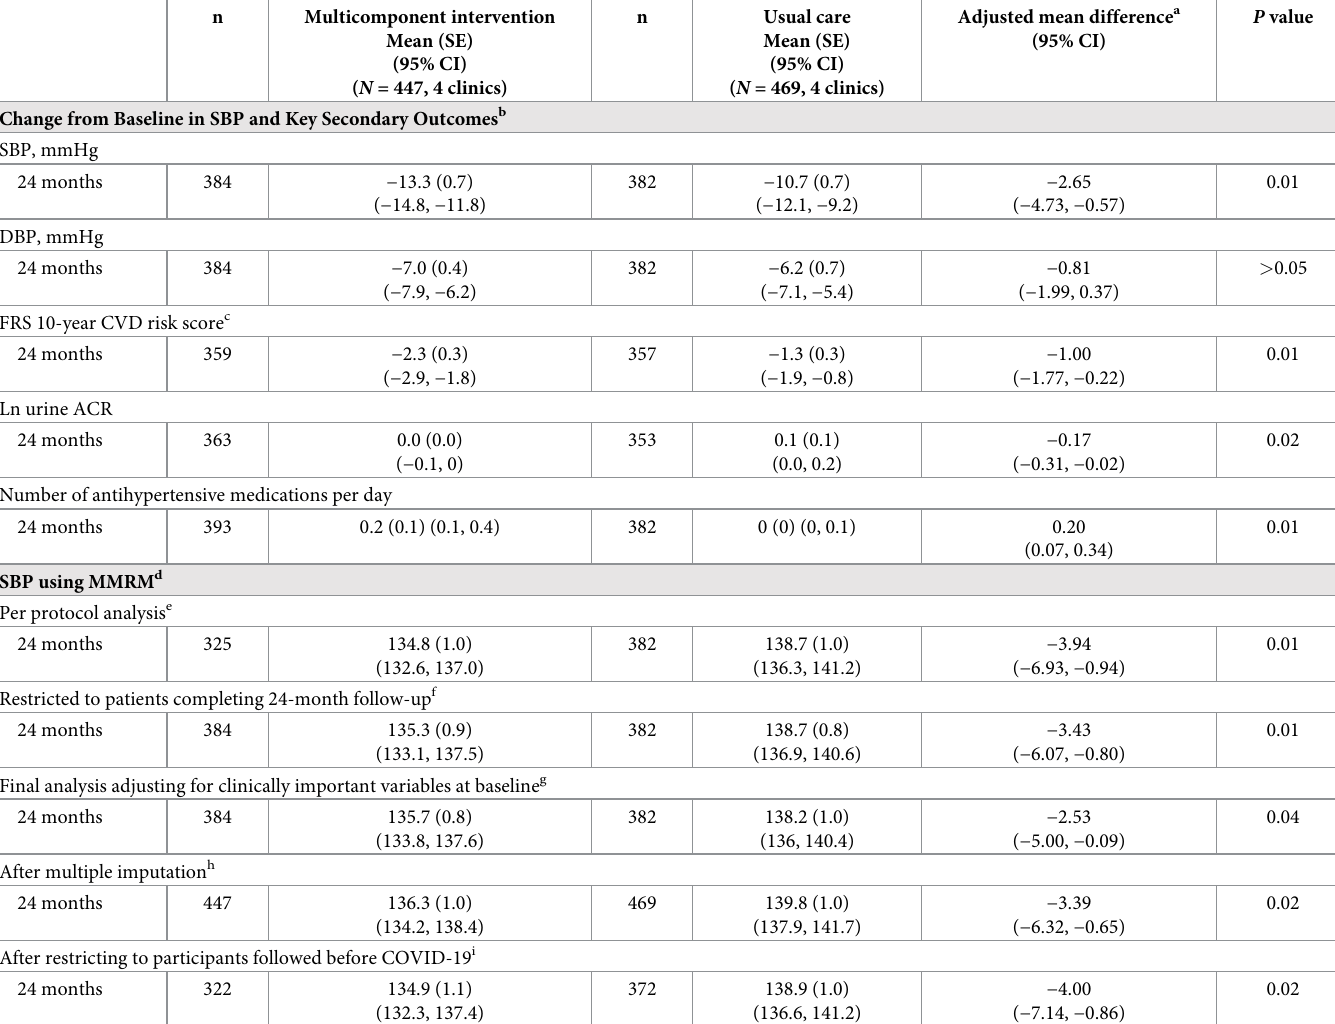
Table 3. Sensitivity analyses of intervention effect on primary and key secondary